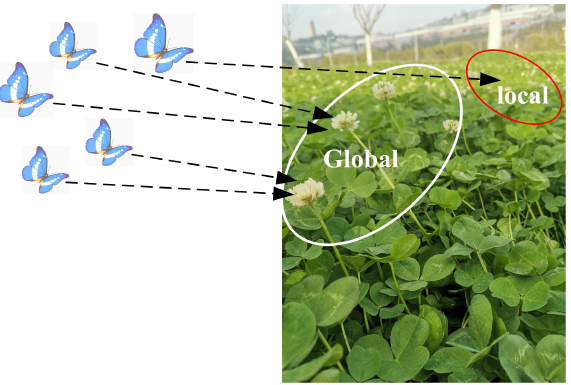
Figure 2. Food foraging of